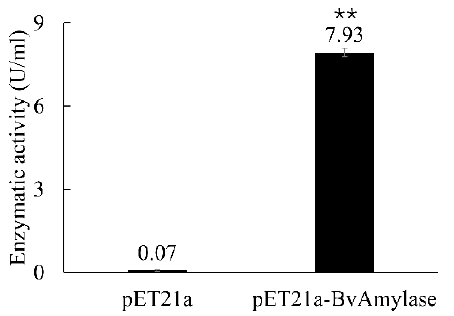
Figure 9. Detection of α -amylase activity for BL21 (DE3) with pET21a-BvAmylase and pET21a. The BL21 cell with pET21a and pET21a-BvAmylase were induced for 24 h, collected, washed, disrupted, centrifuged, and the supernatants were used to measure the α -amylase activity by the DNS method under 40 °C and 20 min. The experimental group was statistically different from the control exper- iment ( p < 0.01), as denoted by double asterisks.